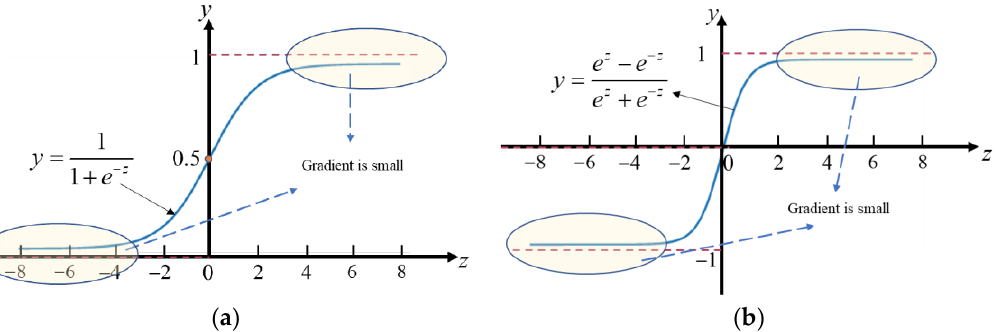
Figure 3. Gradient descent in activation function. ( a ) sigmoid activation function. ( b ) tanh activation function.